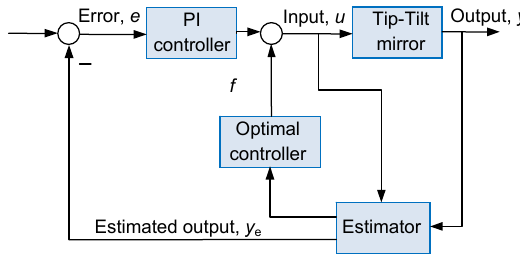
Fig. 2 | LQG control structure of Tip-Tilt mirror.